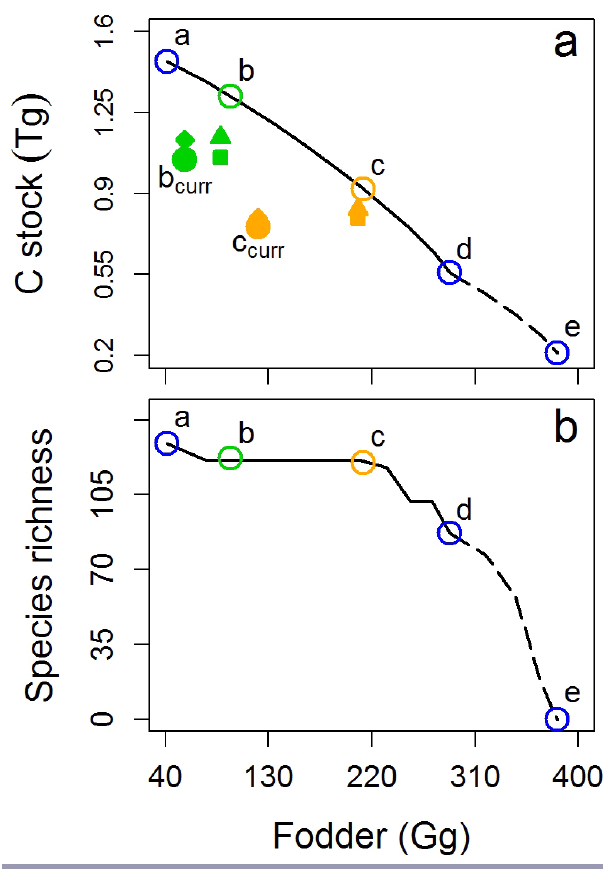
Fig. 3 . Landscape-level efficiency frontiers between (a) fodder and C stock in above-ground living biomass of trees, and (b) fodder and rarified tree species richness for the Chamela- Cuixmala Biosphere Reserve and adjacent areas within a five km buffer. The black continuous line depicts the efficiency frontier when deforestation goes from a completely forested (point a) to a completely deforested landscape outside the CCBR (point d). The discontinuous portion represents the continued efficiency frontier if deforestation extends within the reserve until deforestation of the whole landscape (point e). Points b and c represent the maximum efficiency for low (17%) and high (61%) current deforestation estimates, respectively. Filled points (bcurr and ccurr) are estimates of current service supply under such current deforestation estimates and current management conditions. Other filled symbols represent service supply values under hypothetical management conditions: secondary forest regrowth allowed (diamonds), maximum pasture (triangles), and secondary forest regrowth allowed plus maximum pasture efficiency (triangles). Current service estimates and those under hypothetical management conditions consider that 36% of the forest is secondary.